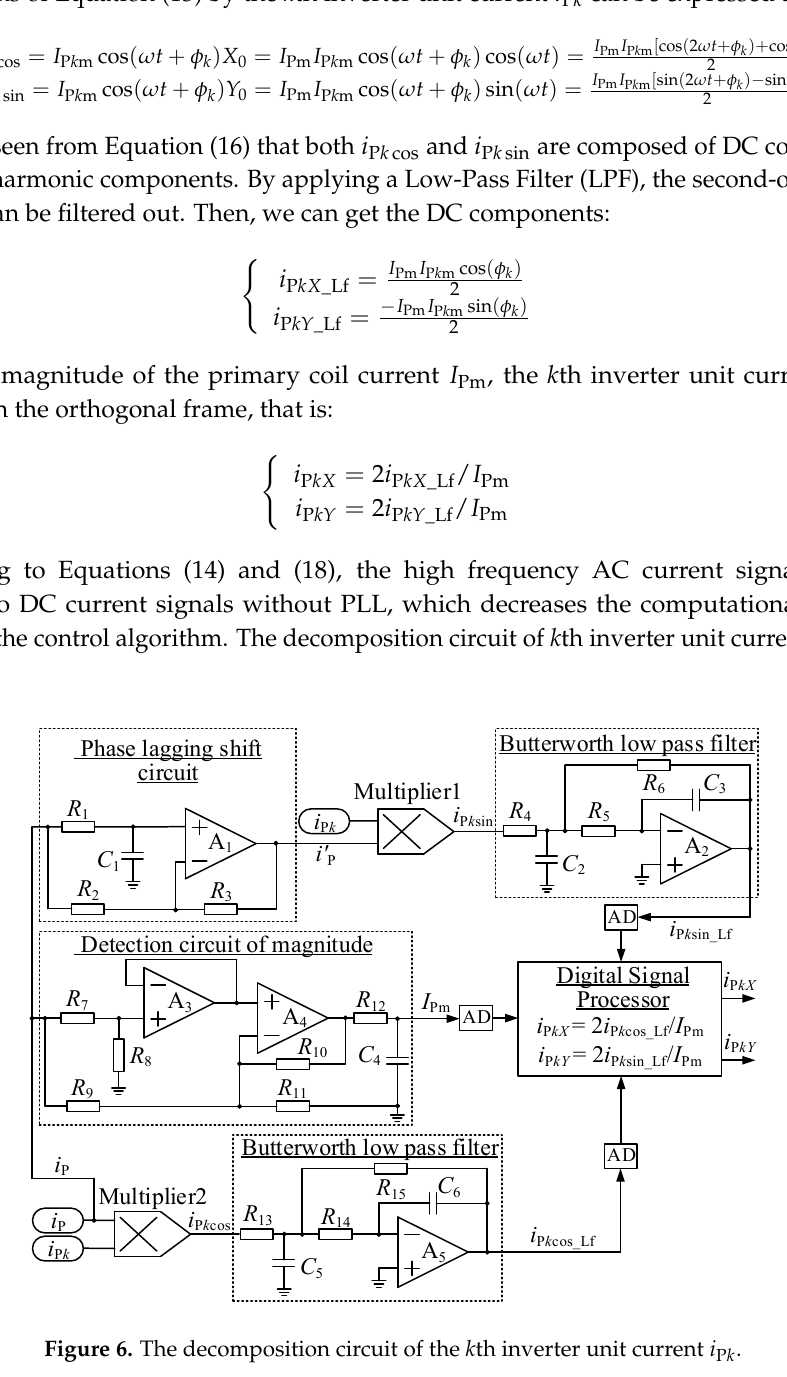
Figure 6. The decomposition circuit of the k th inverter unit current i P k